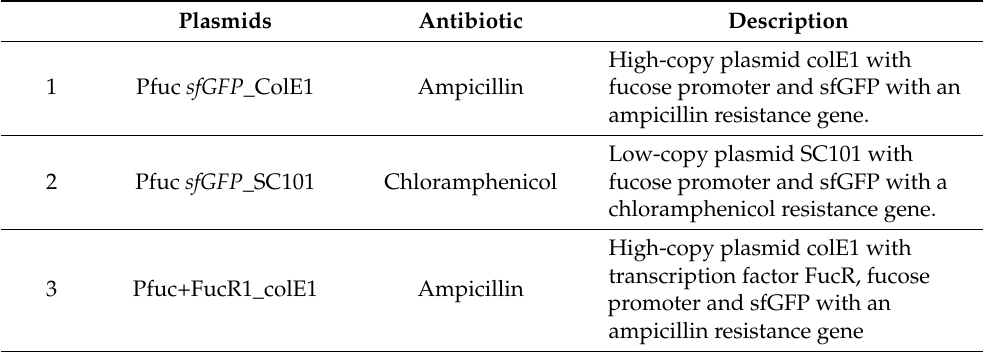
Table 1. Plasmids used in this study. These plasmids were used to transform bacteria that did not metabolize fucose as a carbon source. BL21 and DH5 α colonies were obtained for these plasmids. Plasmids Antibiotic Description High-copy plasmid colE1 with 1 Pfuc sfGFP_ ColE1 Ampicillin fucose promoter and sfGFP with an ampicillin resistance gene. Low-copy plasmid SC101 with 2 Pfuc sfGFP_ SC101 Chloramphenicol fucose promoter and sfGFP with a chloramphenicol resistance gene. High-copy plasmid colE1 with transcription factor FucR, Pfuc+FucR1_colE1 Ampicillin